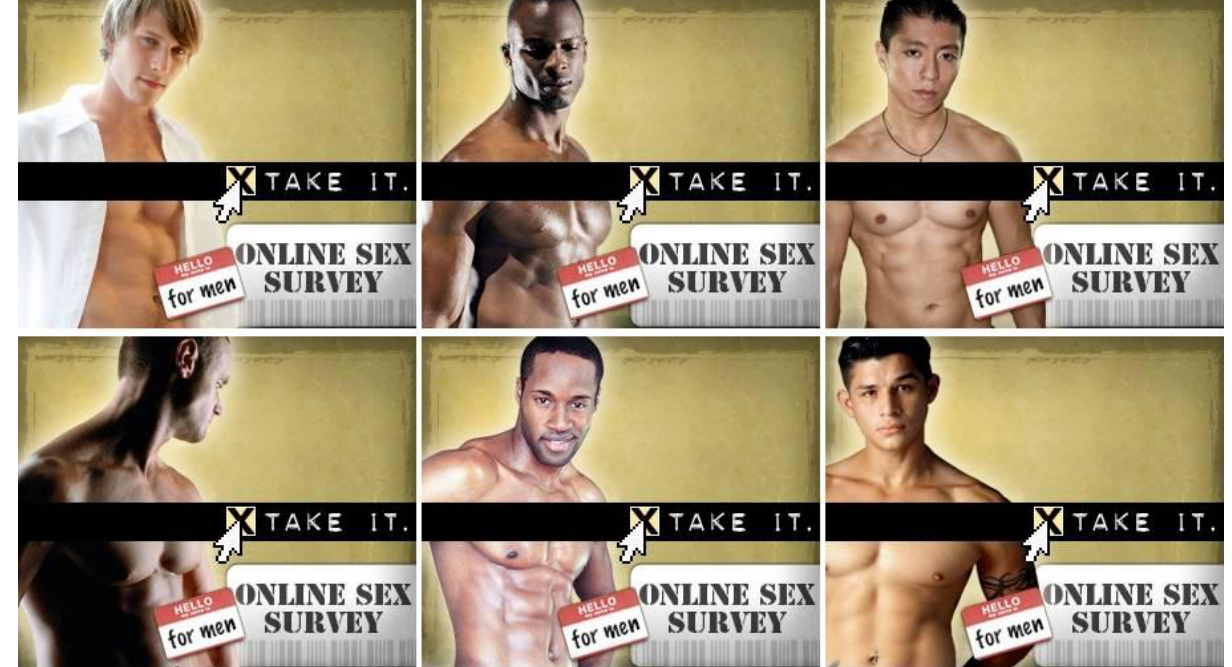
Figure 1. Shown are six banner advertisements displaying white (left), black (middle), and Asian (right) models used to recruit potential participants from MySpace.com for an online HIV behavioral risk study in the United States in 2009